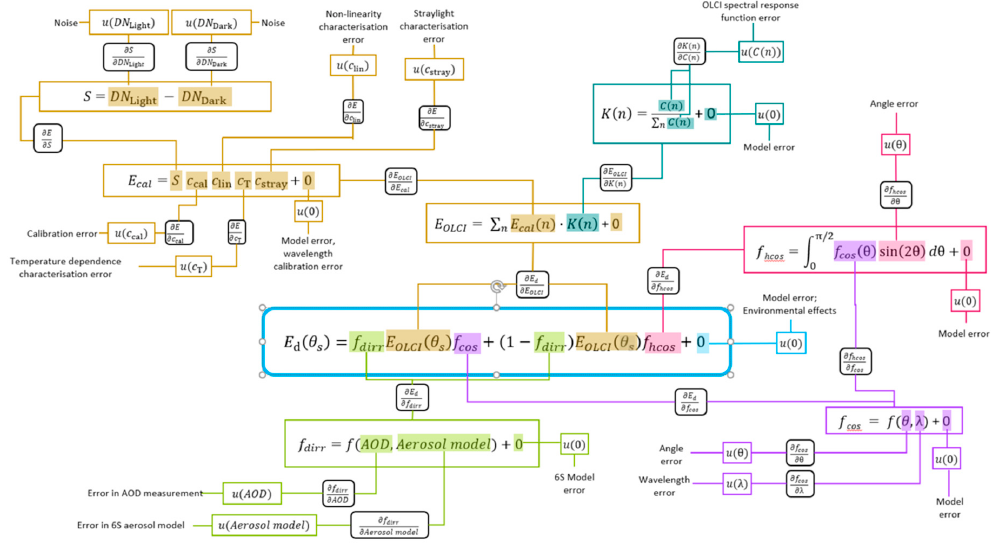
Figure 24. Uncertainty tree diagram for downwelling irradiance ( E d ). Reproduced with permission from [56].